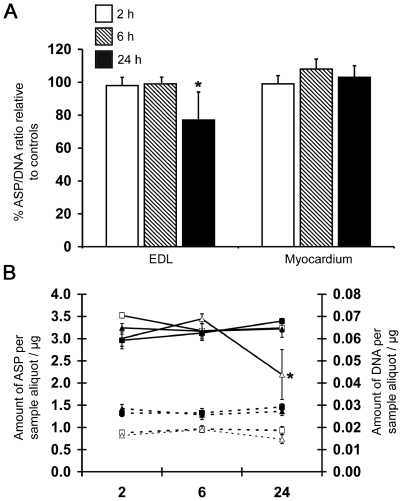
Protein to DNA ratio in muscle and myocardium following LPS infusion.A) ASP to DNA ratio following 2 h, 6 h and 24 h LPS infusion expressed as a percentage of treatment group relative to control groups. Values represent mean±SEM. n = 5–8 per group. B) Quantity of alkaline soluble proteins and DNA in a 20 µl aliquot of muscle extract. Solid lines indicate alkaline soluble proteins; dashed lines, DNA; (□) mean of values from EDL of saline treated animals; (Δ) EDL/LPS; (▪) myocardium/saline and (▴) myocardium/LPS. By two-way ANOVA, significant differences were observed for main effects of treatment (P = 0.02) and time (P = 0.03) and treatment-time interaction (P = 0.02). * indicates significantly different from control (P<0.05).